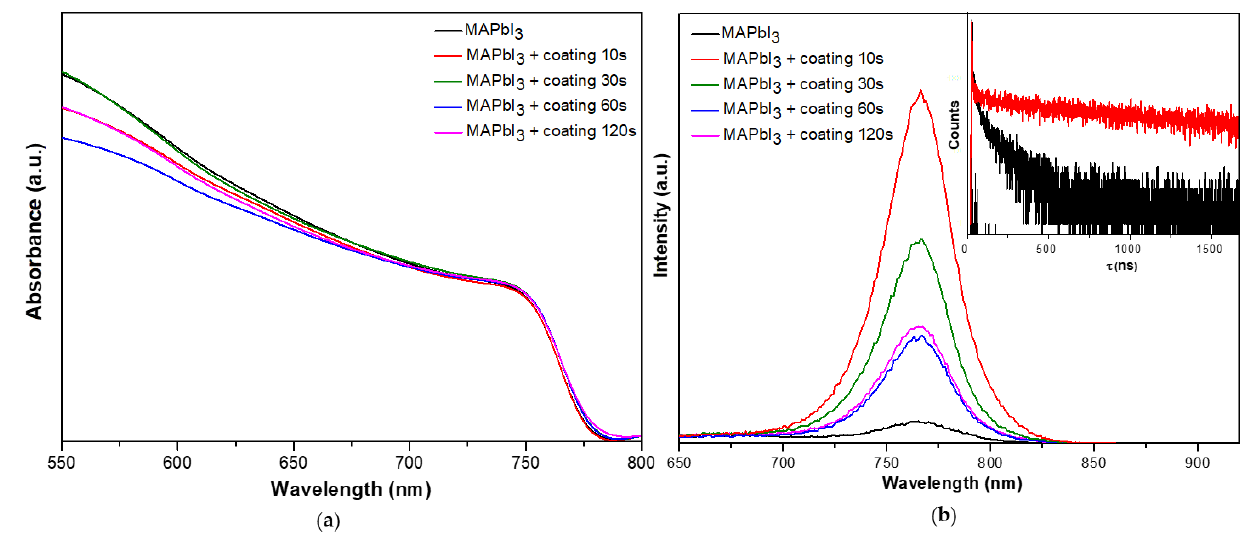
Figure 5. ( a ) UV-vis absorption spectra and ( b ) Steady-state PL spectra of pristine MAPbI 3 film and of samples obtained by the plasma deposition of the fluorocarbon coating performed for 10 s, 30 s, 60 s or 120 s on the perovskite. Inset panel ( b ) time resolved PL decay for MAPI 3 film and 10 s treated ones.